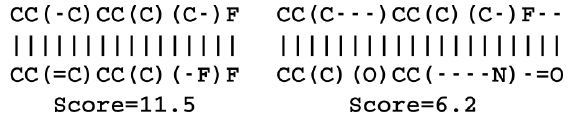
Figure 3. Examples of optimal SMILES alignments of a molecule with two other molecules. The score is +1 for character match, − 1 for mismatch, gap openings − 0.5 and gap extension − 0.05. Gaps are show with dashes, “-”, and are not SMILES single bonds.